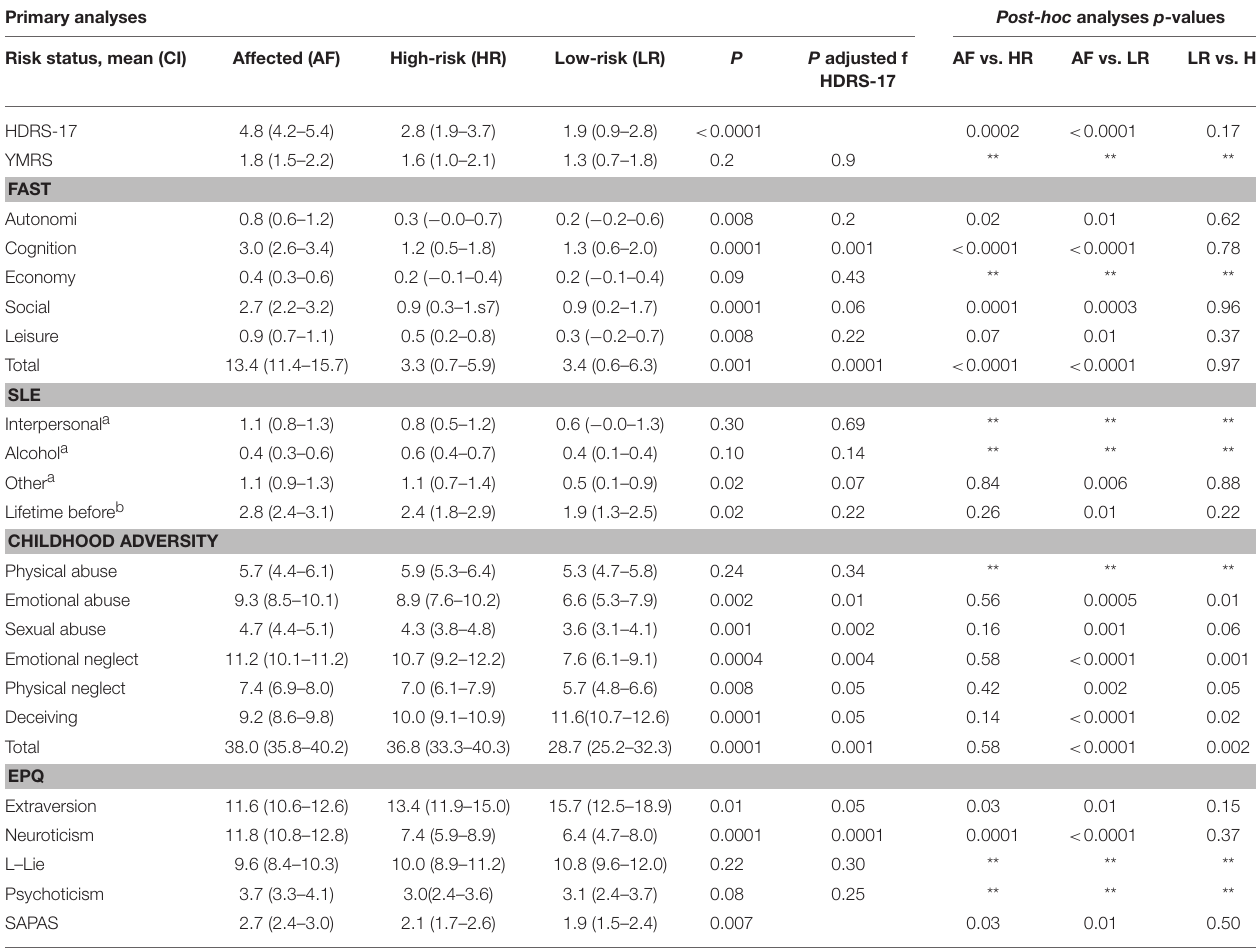
TABLE 5 | Hamilton depression rating scale-17 items (HDRS-17), Young Mania rating scale (YMRS), functional assessment short task (FAST), recent stressful life events (SLE) and life time before, childhood adversity and personality traits according to Eysenck personality questionnaire (EPQ) and standardized assessment of personality–abbreviated scale (SAPAS) in affected, high-risk and low-risk monozygotic twins, in brackets confidence interval (CI). Primary